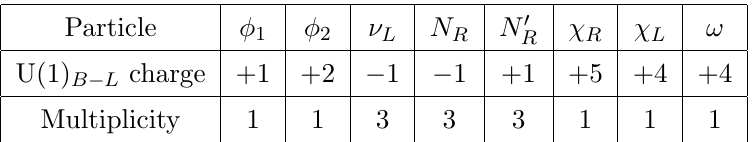
Table 1 . Neutral fermions and singlet scalars with their U(1) B (cid:0) L charge and their multiplicity. (cid:30) 1 ; 2 are SM singlet scalars while N R , N 0 and (cid:31) R are right-handed and (cid:31) L and ! are left-handed R SM singlet fermions